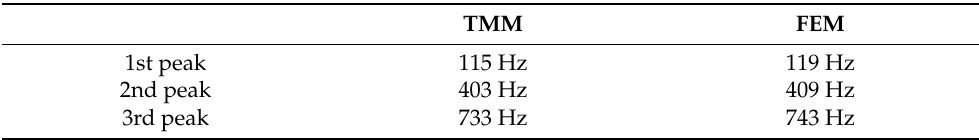
Figure 2. Comparison between the theoretical and numerical results of transmission loss spectra of the ITEC tube; the solid lines represent theoretical predictions by TMM, and the dotted crosses represent simulation results. Table 2. The frequencies correspond to the transmission loss peak.